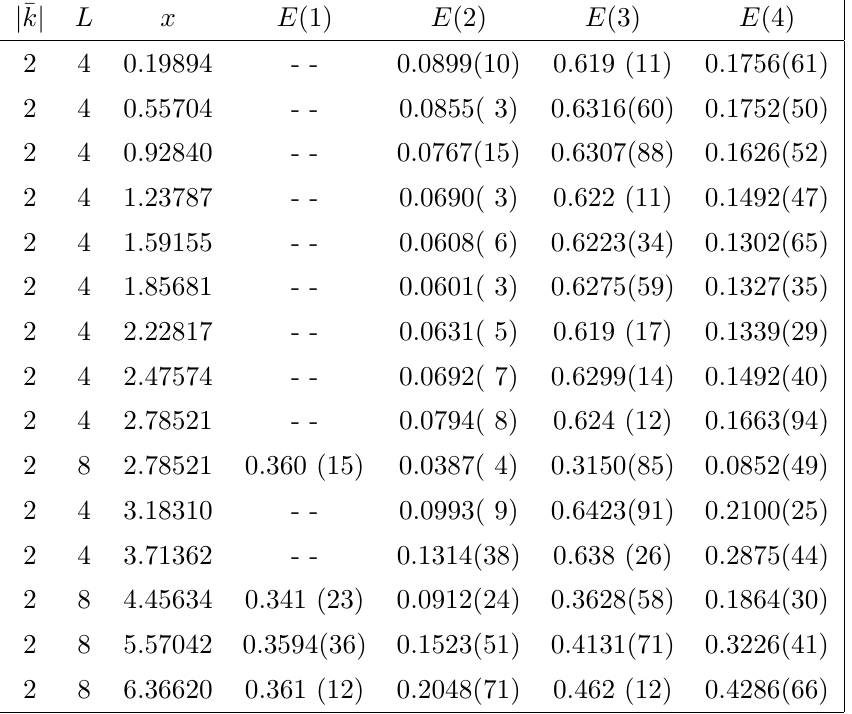
Table 9. SU(17) torelon energies (in lattice units). The states are labelled by the value of the electric (cid:13)ux